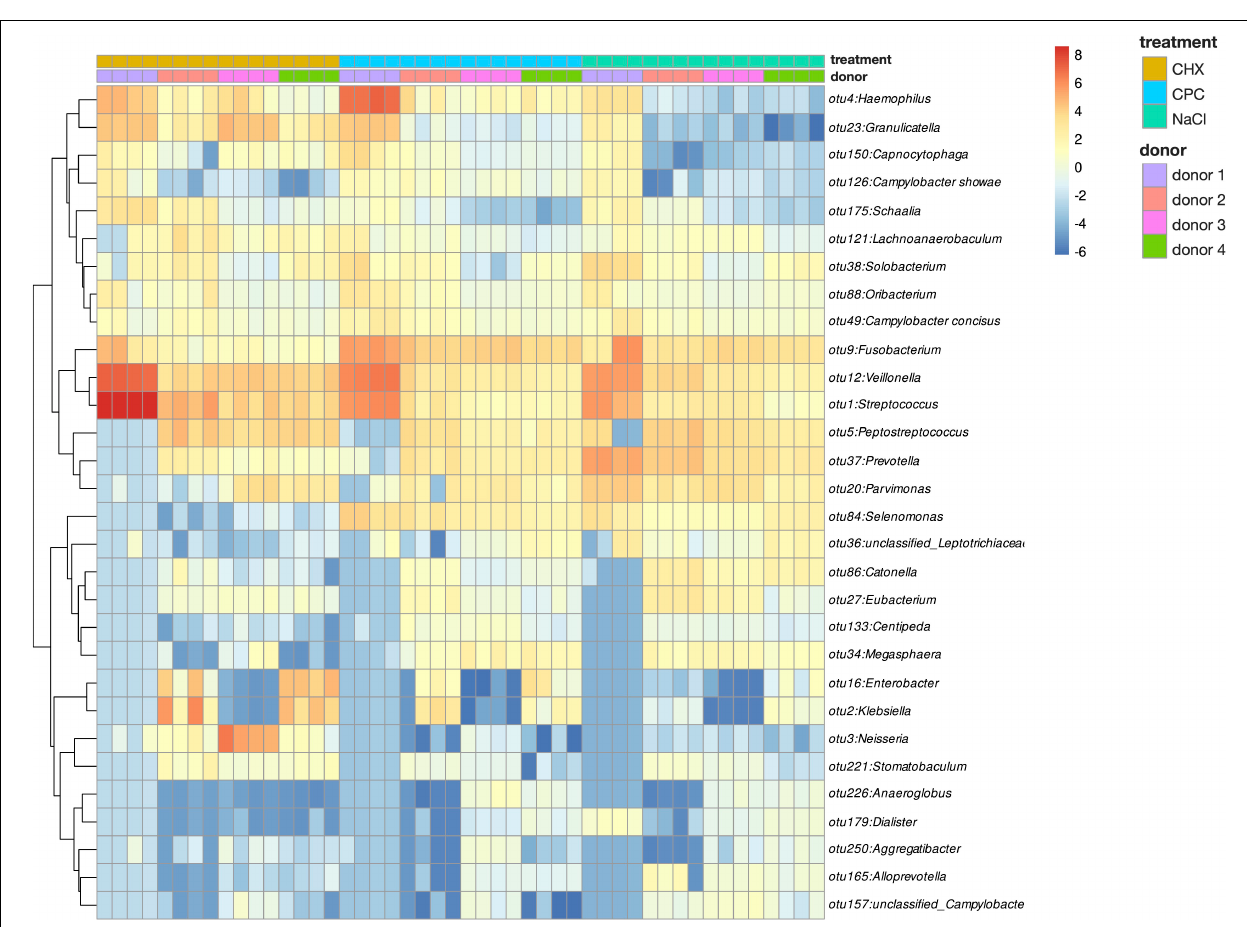
Frontiers in Microbiology |